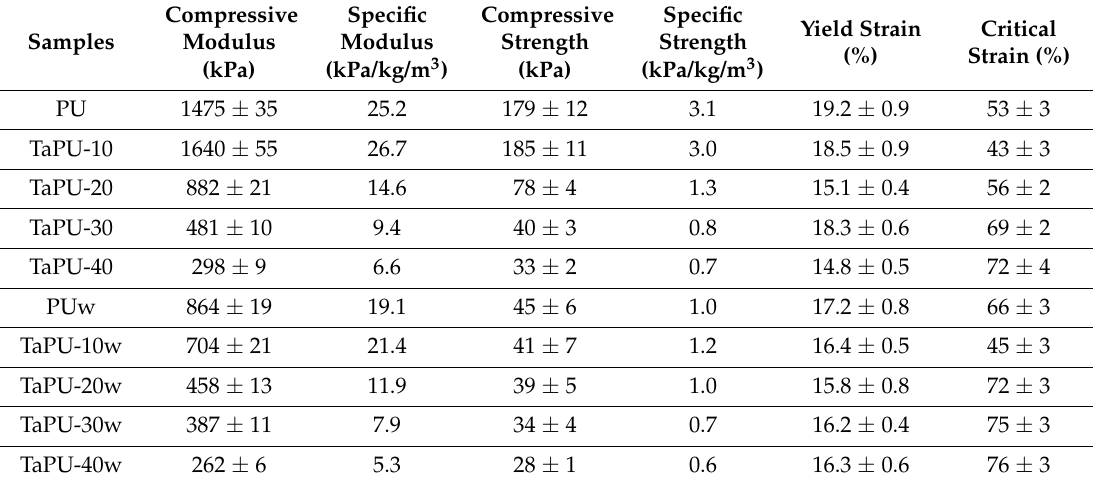
Table 3. Mechanical parameters from compressive tests on PU and TaPU